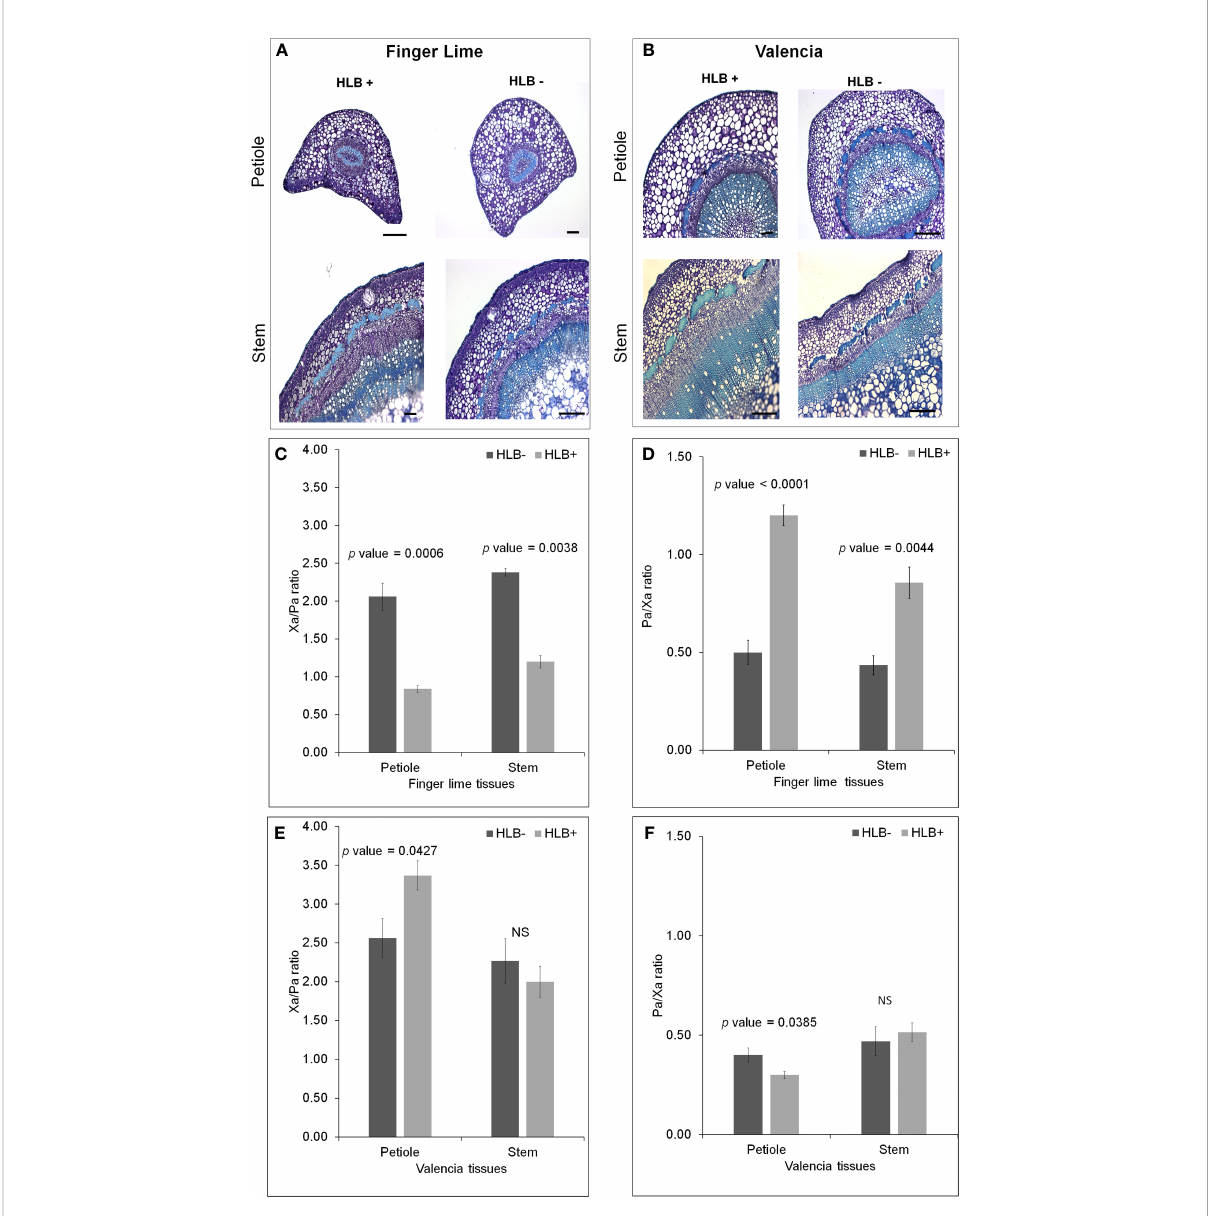
FIGURE 7 Morphological differences between healthy and HLB-infected Finger lime and ‘ Valencia ’ . Bright fi eld images of petiole and stems for each healthy and HLB-infected cultivar, Finger lime (A) , ‘ Valencia ’ (B) . Phloem Ratio (C) and Xylem Ratio (D) in Finger lime and Phloem Ratio (E) and Xylem Ratio (F) in ‘ Valencia ’ . Bars represent standard error. NS, not signi fi cant.